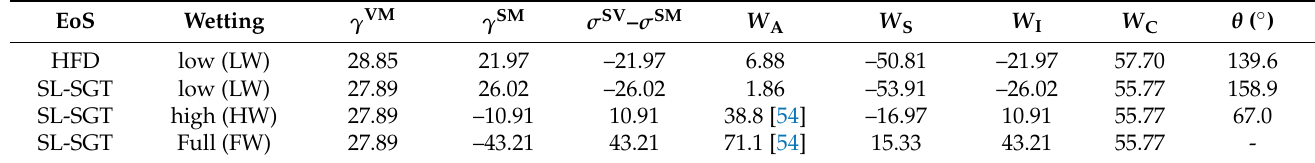
Table 2. Interfacial energies and wetting functions for N m = 384 in units of mJ/m 2 .